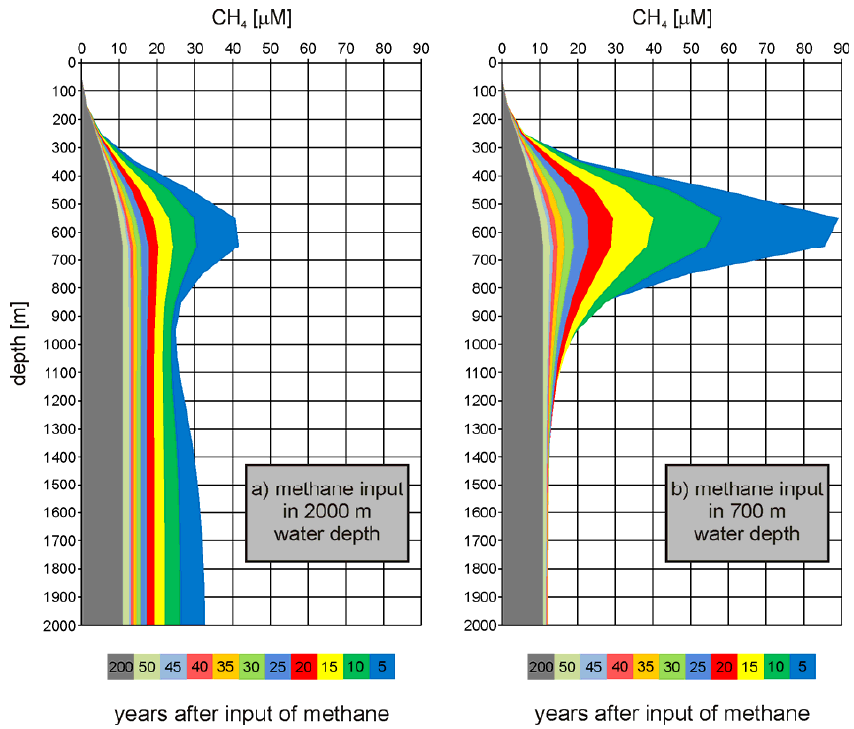
Fig. 4. CH 4 evolution over time after an initial input of 179Tg of CH 4 . The left panel (a) represents the dissolved methane distribution after an input at 700m water depth. The right panel (b) shows the distribution after an input at 2000m water depth. The colour scale indicates the years after the input event. The gray area represents the final steady state methane concentration in the Black Sea water